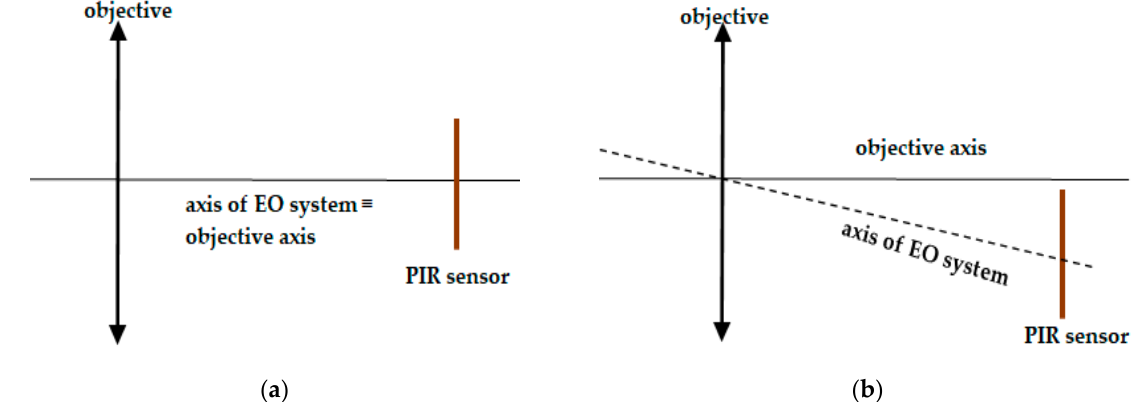
Figure 2. Illustration of the optical axis of a PIR sensor module in perfect alignment ( a ) and in imperfect alignment ( b ). The challenge of determining the position of the optical axis for a prebuilt PIR sensor module is that the module is a non ‐ imaging EO system; thus, the only data are the output voltage signals over time. In addition, there are also many noise sources, such as unex ‐ pected radiation noise, Johnson noise, amplifier noise, etc. [1], that might affect the output signal of the sensor. Therefore, a setup for measuring the centering error of a PIR sensor module should be built based on the working principle of PIR sensor and the definition of the optical axis of the module. Moreover, the setup should obtain appropriate measure ‐ ment sensitivity to define the position of the optical axis of the module with a desired resolution, regarding the presence of noises. The aim of this study is to construct an experimental setup for defining the position of the optical axis and the centering error. In this setup, an infrared radiation source mod ‐ ulated at a specific frequency is presented and the analysis for parameter settings to en ‐ hance the measurement sensitivity is described. The centering error of the PIR sensor module was determined through the sensor output response to the modulated heat source. Thus, the consecutive sections are constructed as follows. Section 2 describes the working principle of the PIR sensor module which are similar/popular. Section 3 presents the measurement setup with the analysis that points out specific setting parameters that would assist the measurement sensitivity. Section 4 supports the reliability of the pro ‐ posed setup by providing practical measurements for two PIR sensor modules with spe ‐ cific signal processing methods. 2. Dual ‐ Element PIR Sensor Module The housing of the dual element PIR sensor module was made based on a mechanical design (Figure 3) in order to assemble a Fresnel lens, a dual ‐ element PIR sensor, and elec ‐ tronic board for processing the sensor’s output signal. The lens used in the module was a single ‐ zone Fresnel lens F50.9 from KUBE Electronics AG [14], which played the role of an objective for the EO system. The dual ‐ element PIR sensor was an IRA ‐ S230ST01 sensor from Murata Manufacturing Co., Ltd [15]. Both the sensor and the lens worked with the infrared wavelength range of 5 μ m ÷ 15 μ m, which features the surface temperature range of − 80 °C ÷ 300 °C, due to the Wein displacement law [16]. The PIR sensor was supposed to be placed at the focal point of the Fresnel lens ( f = 50.9 mm). Such an alignment has appeared in most applications of PIR sensors.